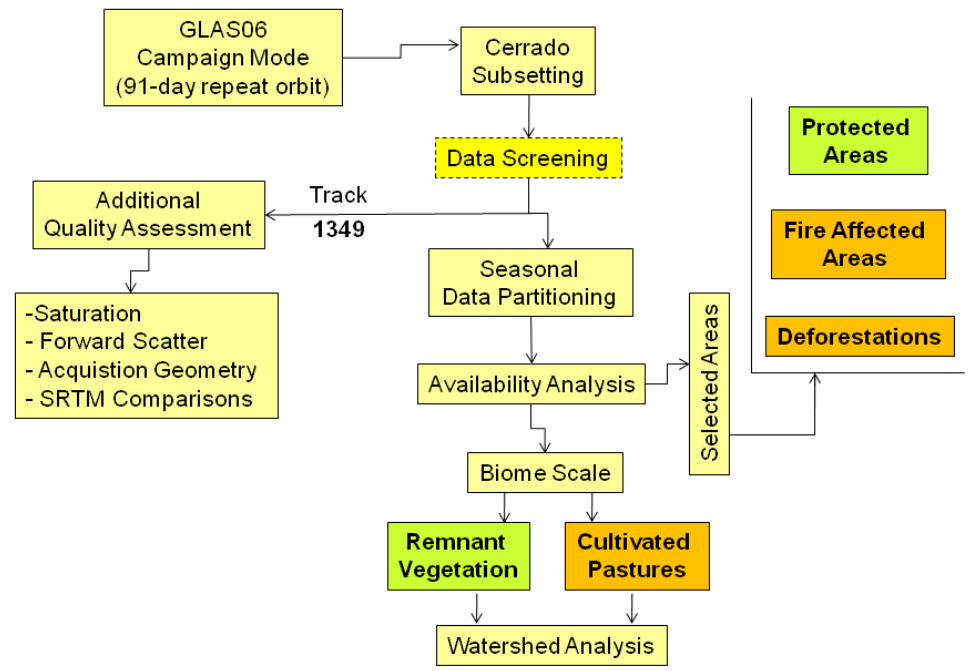
Figure 1. Flowchart depicting the organization, processing, and analysis of GLAS data availability over the Cerrado